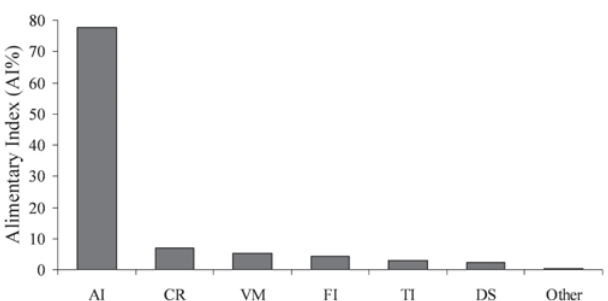
Fig. 2. Alimentary Index (%) of food categories consumed by the fish community of the Nova Avanhandava Reservoir. AI = Aquatic insect; TI = Terrestrial insects; CR = Crustaceans; FI = Fish; MA = Macroinvertebrates; MI = Microcrustaceans; AL = Algae; VM = Vegetal matter; DS = Detritus/sediment; SC = Scales. The acronyms of species are in Table